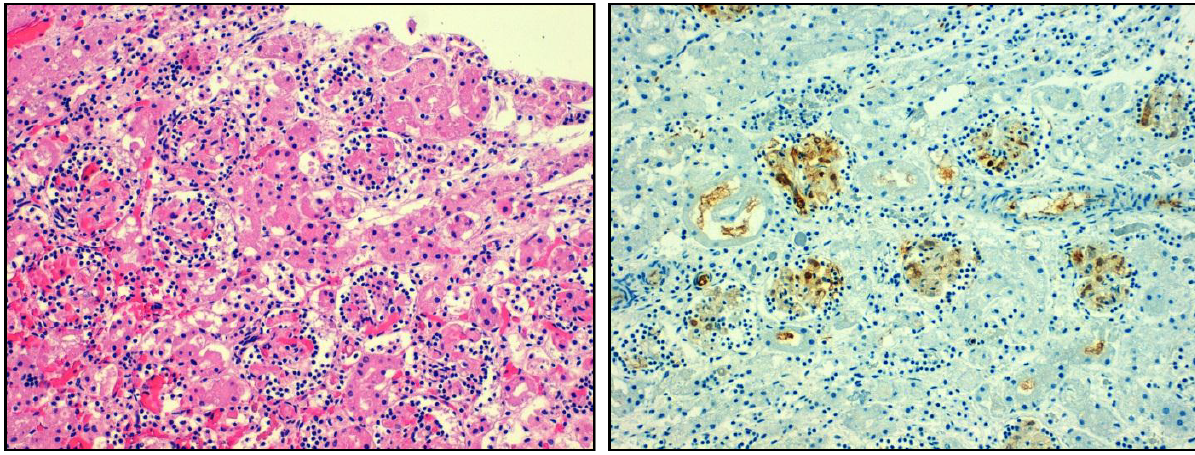
Figure 2. Overshooting clotting in thrombotic microangiopathy. Local activation microvascular endothelial cells and lack of distinct inhibitory factors can lead to thrombotic microangiopathy which is characterized by microthrombi obstructing arteriolar and glomerular vessels, a lesion associated with significant inflammatory cell infiltrates ( left ). Fibrin immunostaining displayes clot formation within glomeruli ( right ). Original magnification